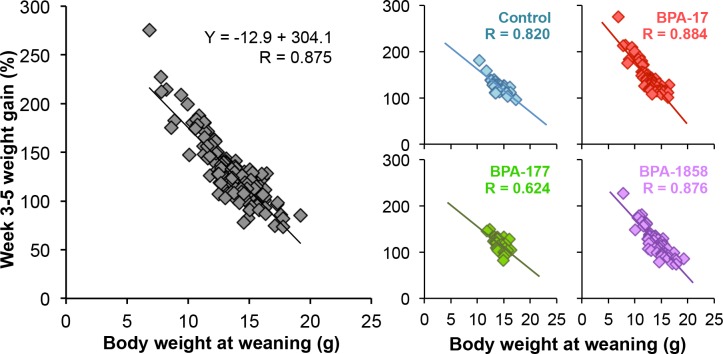
Relationship between weaning weight and post-weaning weight gain between week 3–5 in male mouse offspring.Left: data for all animals without regard to perinatal treatment, and Right: the slopes and correlation coefficients for each individual treatment group.